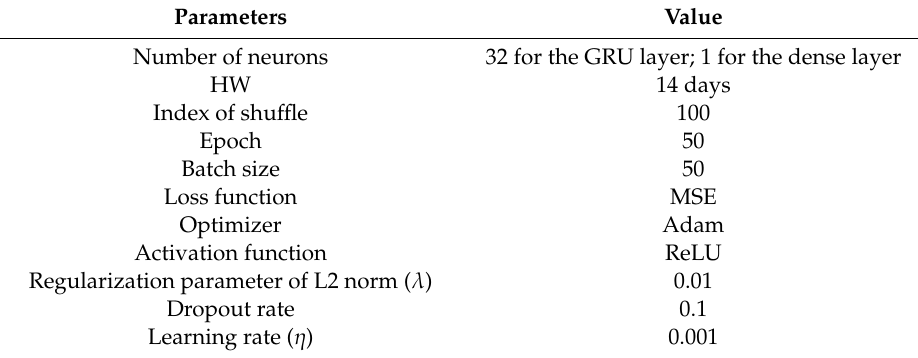
Table 2. The parameters of the trained GRU